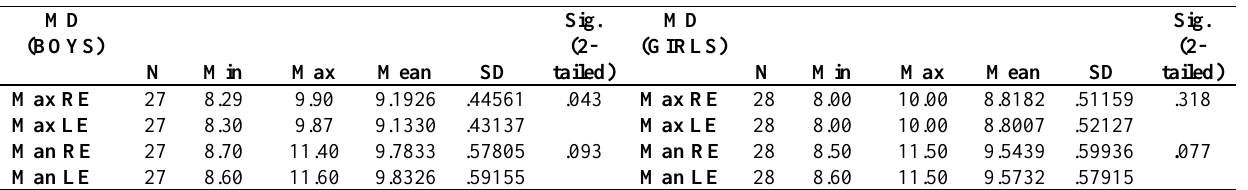
Table 1: Comparison between right and left sides differences of maxillary and mandibular MD width of second primary molars for both genders.